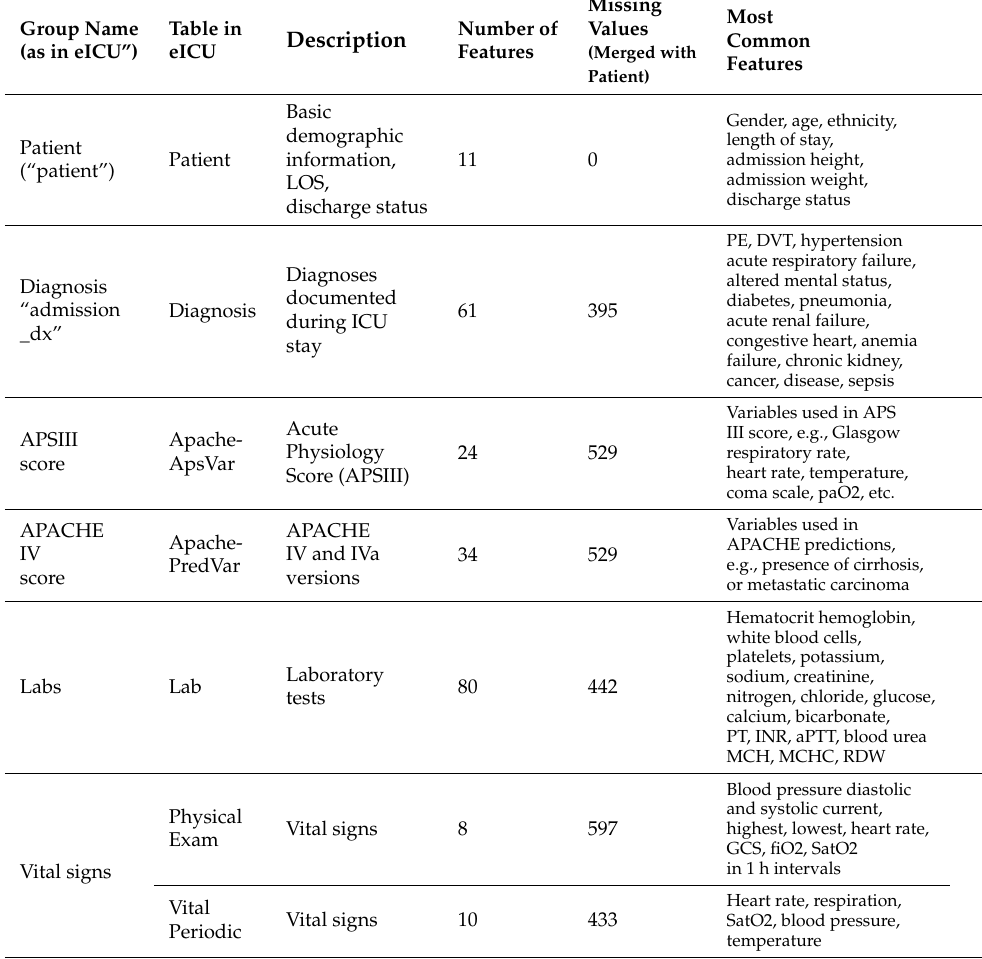
Table A1. Description of attributes selected for patients with thrombosis and/or cancer from the various tables of eICU dataset. NOF denotes the number of features, and MD the missing